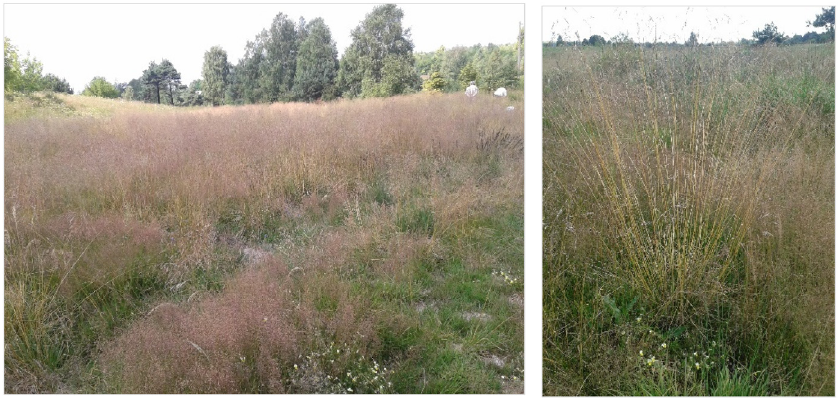
Figure 1. A wasteland near a zinc smelter in Bukowno near Olkusz, Poland, colonized by Deschampsia caespitosa . Table 2. The concentration of metals in the soil from the D. caespitosa site in Bukowno near Olkusz. Sample No.